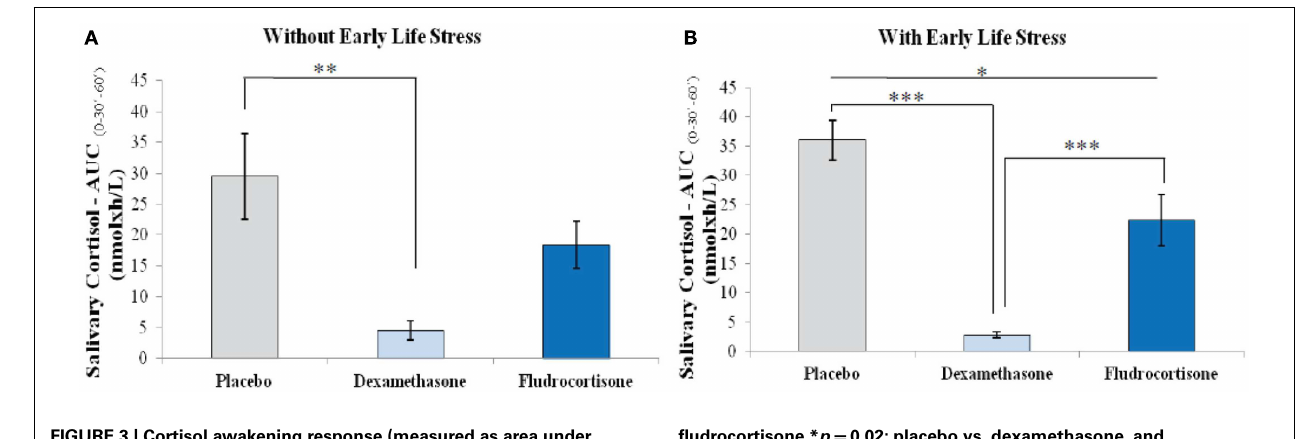
FIGURE 3 | Cortisol awakening response (measured as area under the curve) after placebo, dexamethasone (GR agonist), and fludrocortisone (MR agonist) in (A) depressed patients without early life stress ( n = 7); placebo vs. dexamethasone ** p < 0.01 and (B) depressed patients with early life stress ( n = 13); placebo vs.